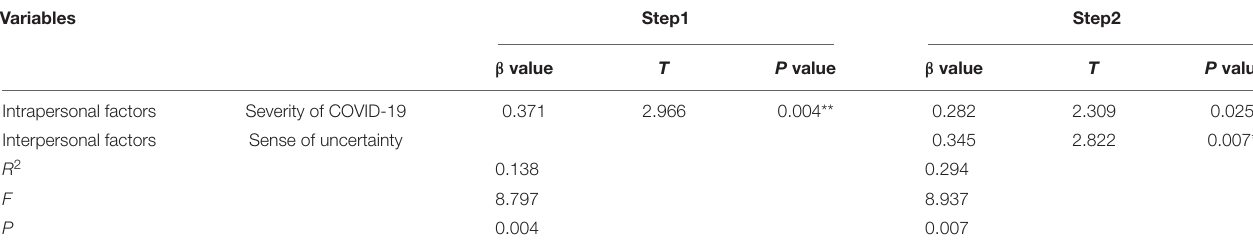
TABLE 3 | Hierarchical multiple regression analysis of psychological distress among the patients with COVID-19.